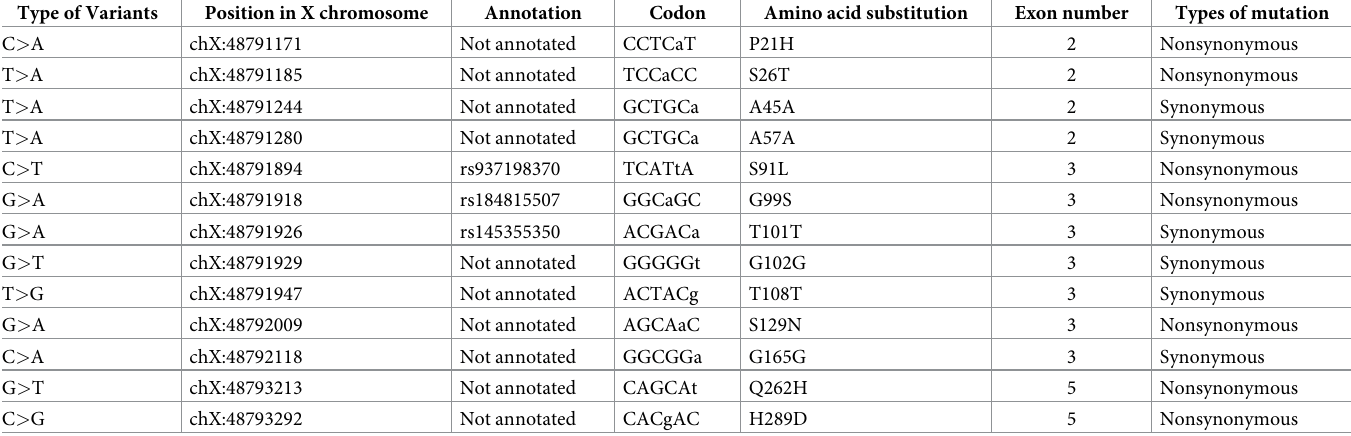
Table 3. Variations of GATA1 gene and their subsequent amino acid changes in protein sequence.